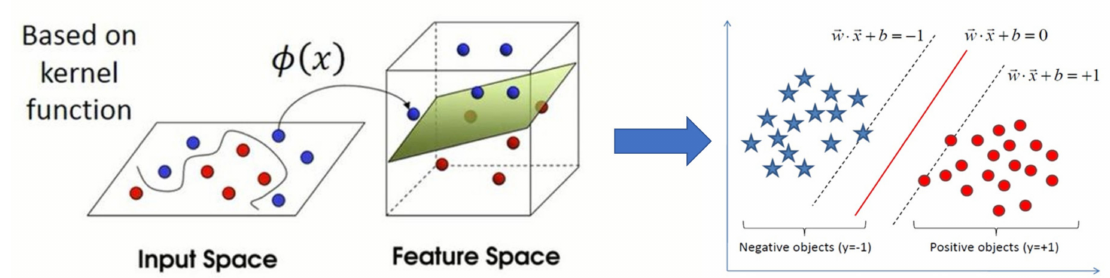
Figure 3. Schematic diagram of the support vector machine (SVM)